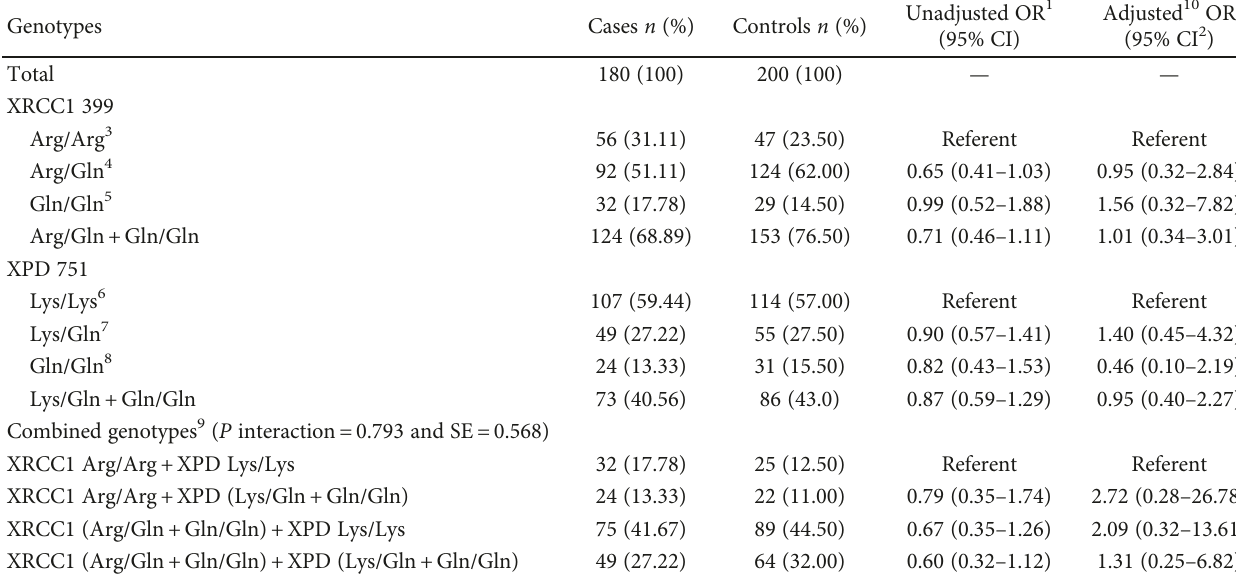
Table 3: Independent and combined genotypic distribution of XPD and XRCC1 in gastric cancer cases and matched